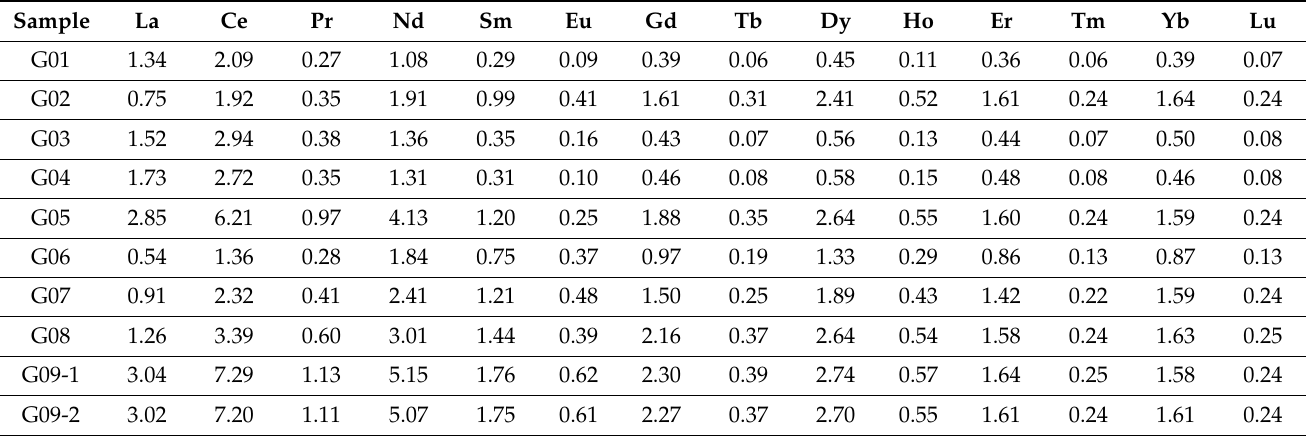
Table 3. Rare earth element content of Gongchangling magnetite rich ore, altered wall rock, and amphibolite.